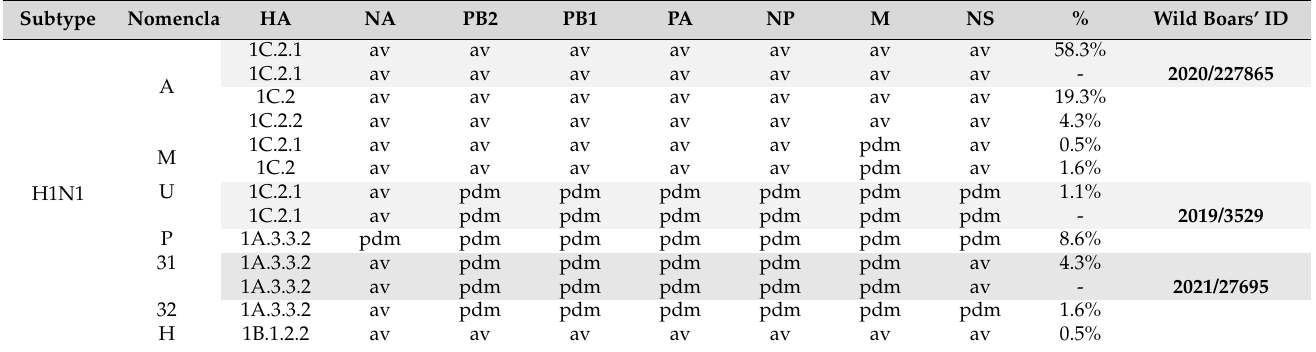
Table 2. Data analysis of the genotypes among the H1N1 subtype detected in wild boars; strains were assigned to the corresponding genotype, as previously described [13,15,37]. The wild boars’ SwIAVs were compared to the strains circulating in swine farms (data from